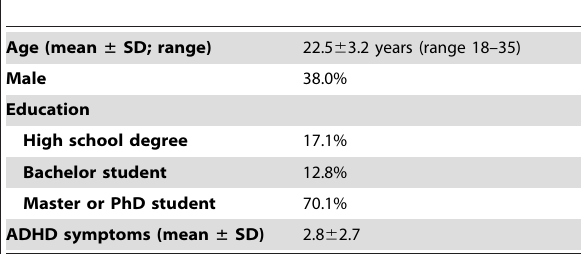
Table 1. Demographics of the study sample